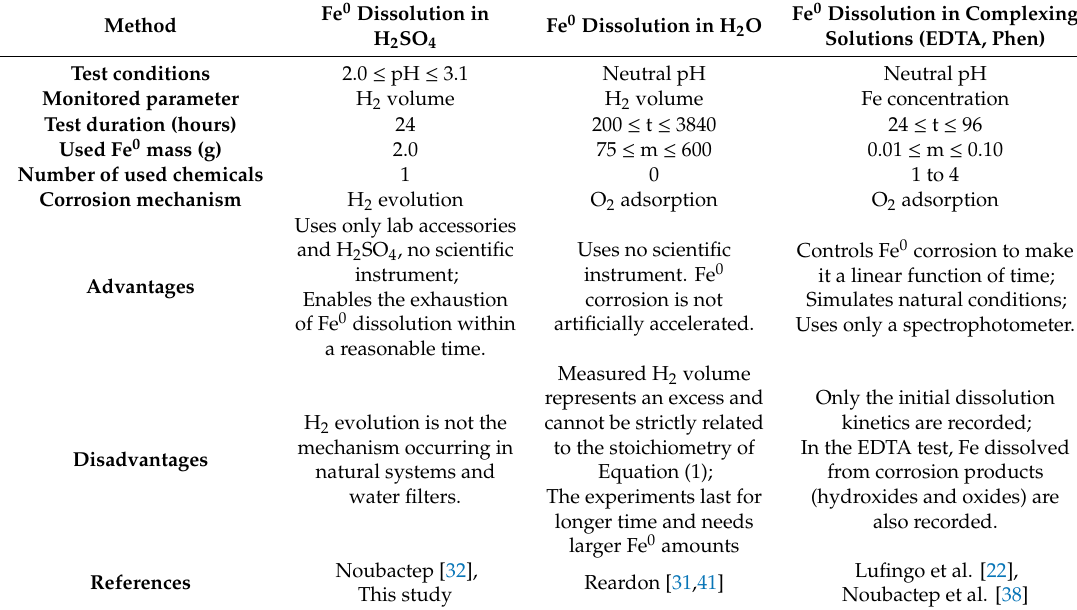
Table 2. Comparison of used Fe 0 reactivity characterization methods for materials selection for water